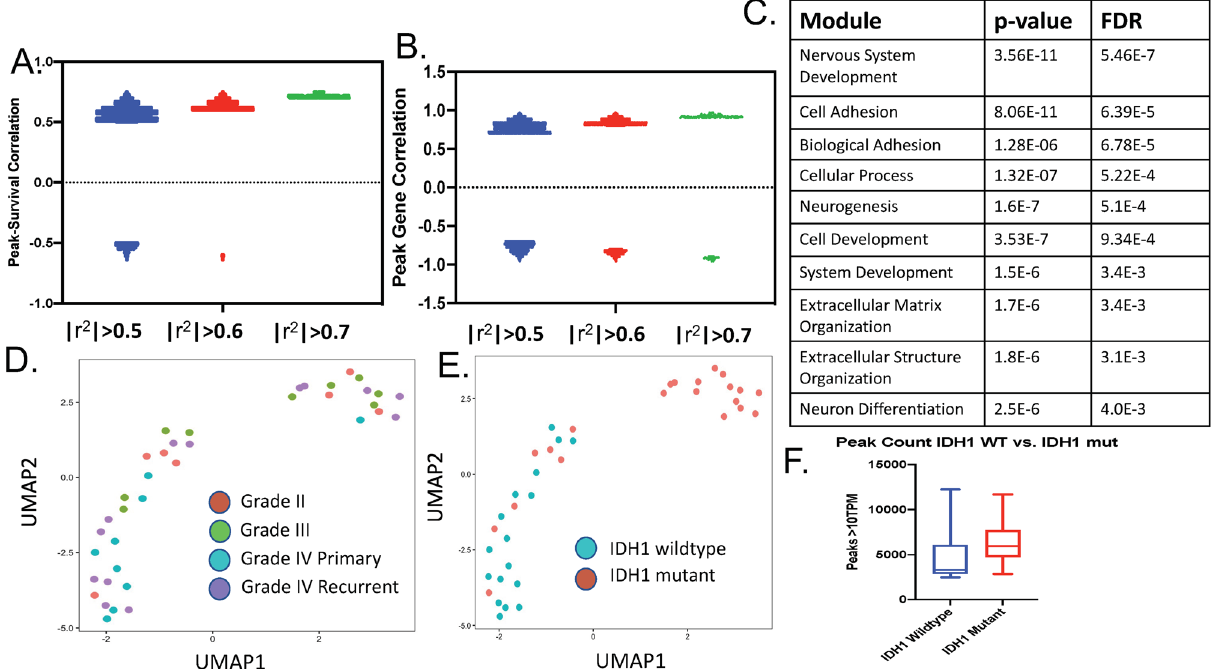
Figure 1. ( A ) Univariate correlations between peaks and survival are plotted above for |r 2 | > 0.5, |r 2 | > 0.6, and |r 2 | > 0.7. The vast majority of the correlations between peaks and survival are positively correlated. ( B ) Univariate correlations between peaks and genes are plotted above for |r 2 | > 0.5, |r 2 | > 0.6, and |r 2 | > 0.7. The vast majority of the correlations between peaks and genes are positively correlated. ( C ) Peak-gene correlations of |r 2 | > 0.6 were subjected to gene ontology analysis. Significantly enriched gene modules are shown above. ( D,E ) UMAP clustering of all 38 samples coded by grade ( D ) and IDH1 status ( E ). ( F ) Total peaks (Transcript per million).